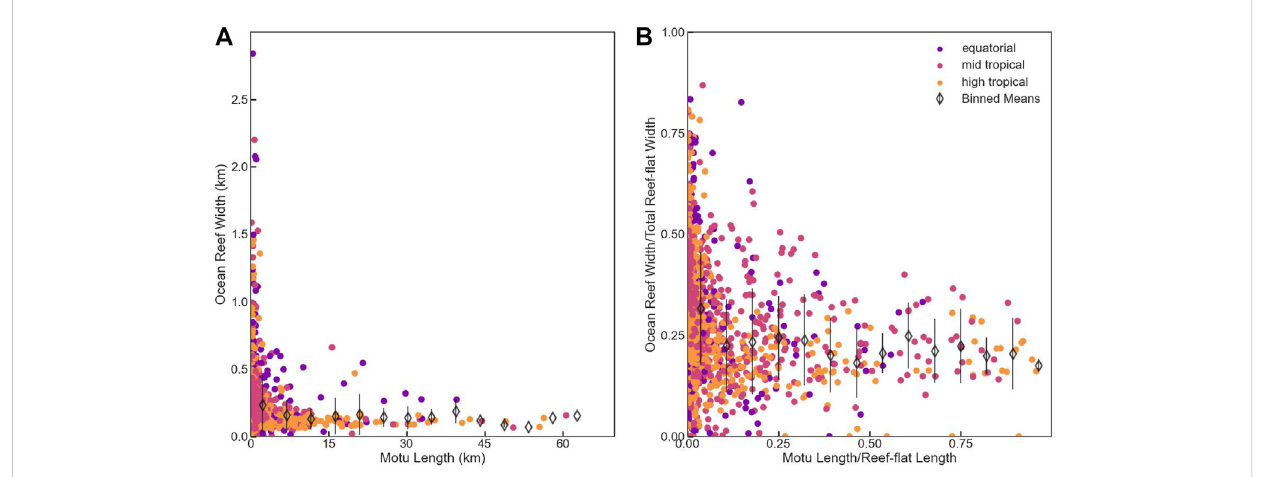
FIGURE 12 (A) Reef fl at width in front of motu (ocean reef width) vs. motu length on a per motu basis classi fi ed by latitude (n = 1,733) with mean ocean reef- width (black diamonds) binned per motu length with standard deviation. (B) Reef fl at width in front of the motu normalized by the width of the total reef fl at under the motu vs. the motu length normalized by the length of the reef fl at the motu is on classi fi ed by latitude with mean normalized ocean reef- width(blackdiamonds)binnedpernormalizedmotulength withstandarddeviation.Eachcircularpointrepresentsonemotuclassi fi edasequatorial atolls (purple): 0 ° – 4.7 ° , mid tropical atolls (pink): 4.7 ° – 14 ° , and high tropical atolls (orange): > 14 ° .